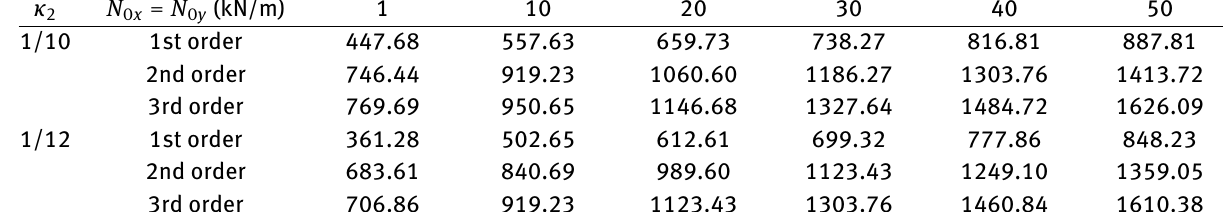
Table 3: The natural frequencies (rad/s) of numerical solutions under different prestress and rise span ratios κ 2